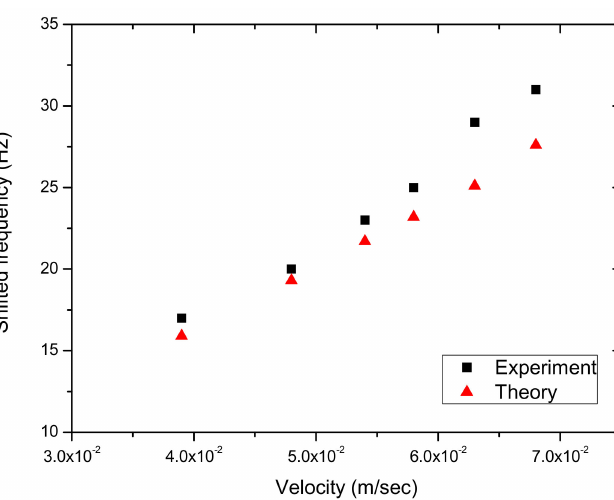
Figure 18. A comparison of the measured and predicted shifted